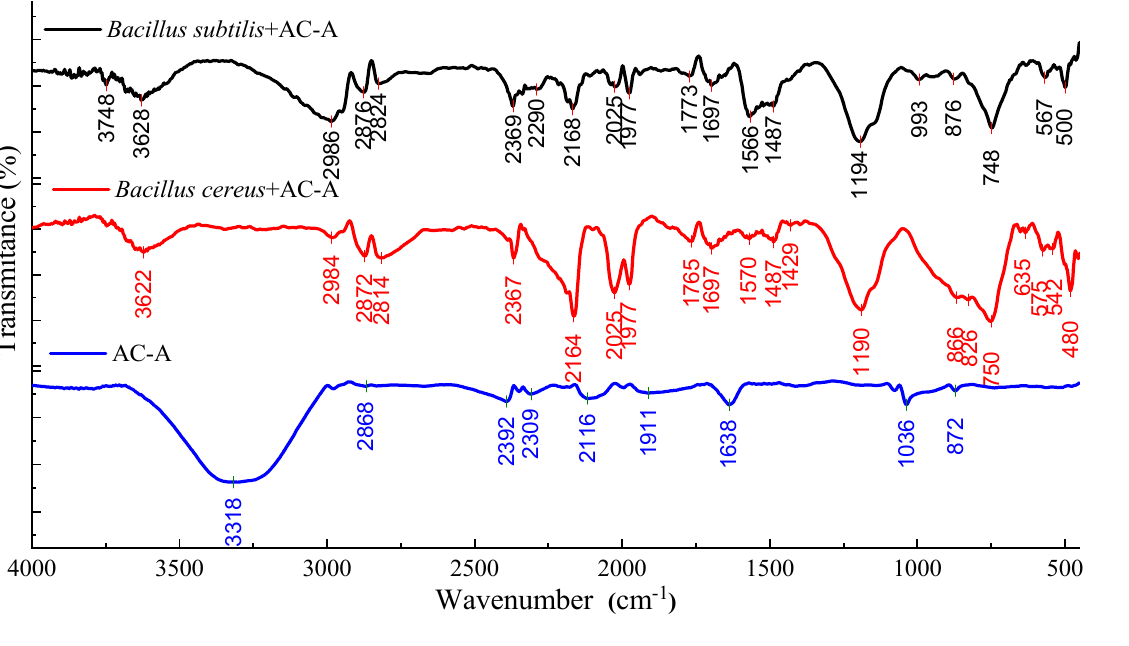
Figure 6. FTIR spectra of B . subtilis and B. cereus bacteria adsorbed on the AC-A enterosorbent and the intact AC-A enterosorbent.